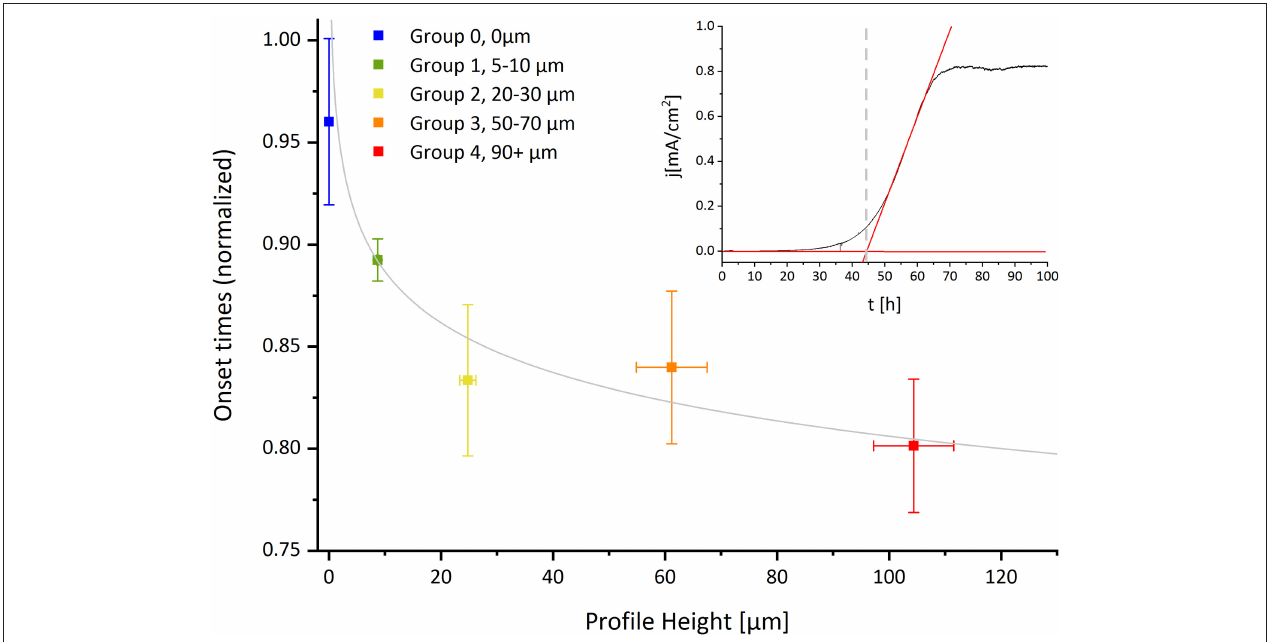
FIGURE 3 | Main figure: Onset times for the bioelectrocatalytic current generation normalized to the slowest value, as a function of the electrode’s average structure heights. Inset Figure: Illustration of the graphical method to determine the onset (lag) time of the biofilm formation from the chronoamperometric curve.